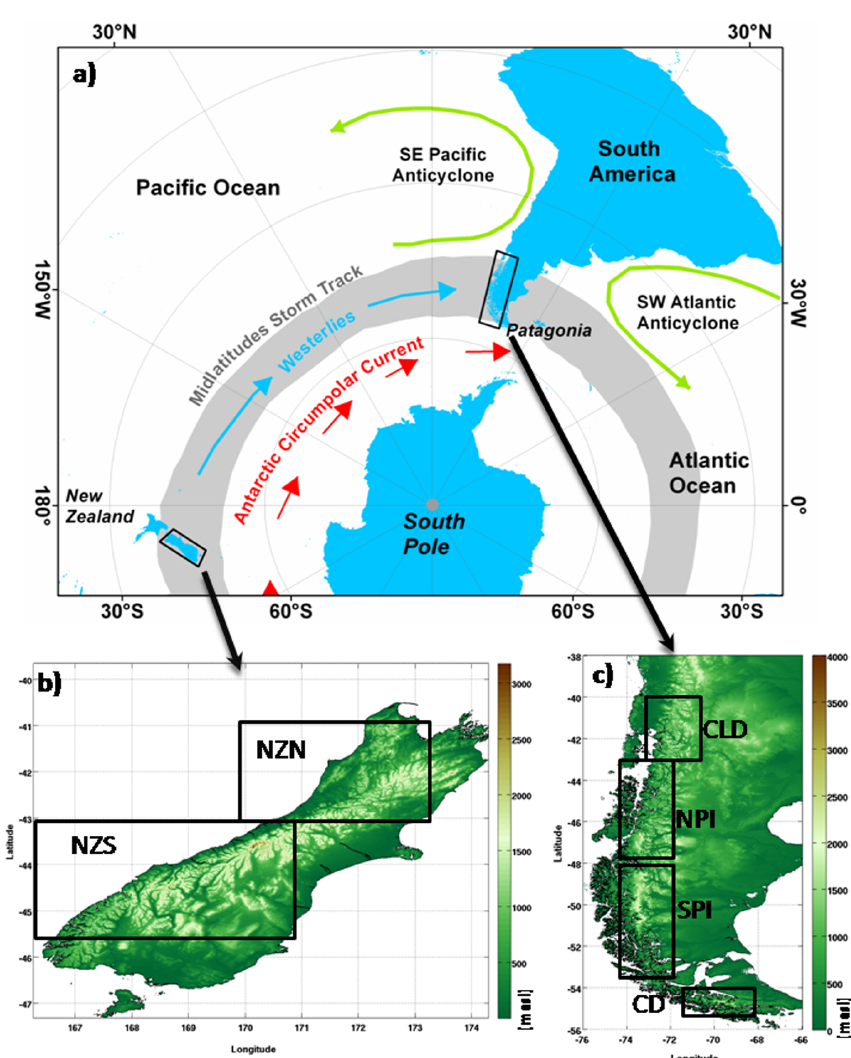
Figure 1. Study area. (a) Schematic diagram showing some of the main climate characteristics in the southern mid-latitudes. (b) New Zealand South Island topography and the two zones of analysis (NZN: New Zealand north; NZS: New Zealand south). (c) Patagonia topography and the four zones of analysis (CLD: Chilean Lake District; NPI: Northern Patagonian Icefield; SPI: Southern Patagonian Icefield; CD: Cordillera